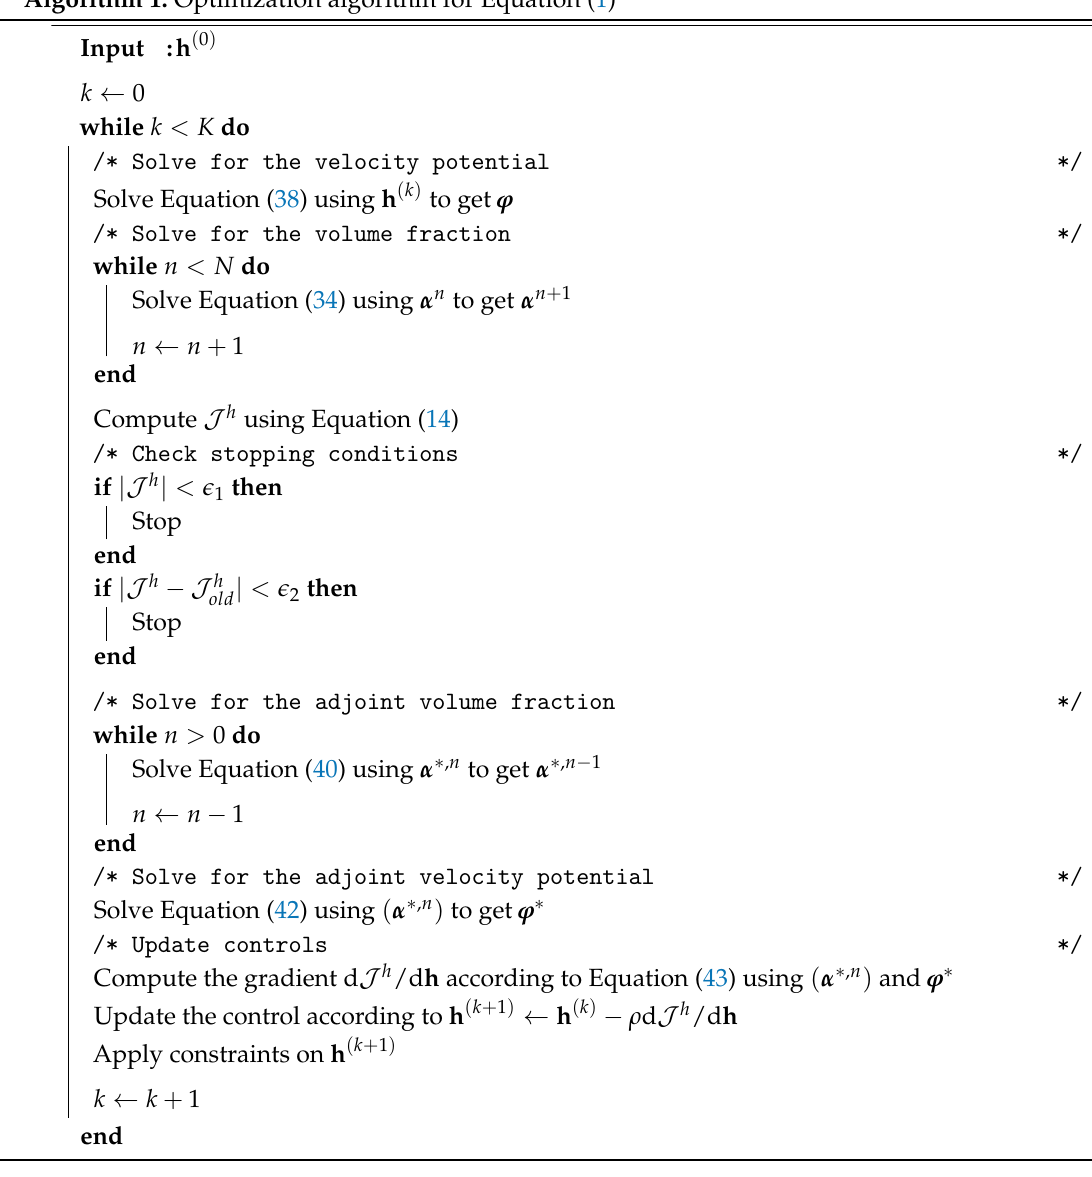
Algorithm 1: Optimization algorithm for Equation (1)